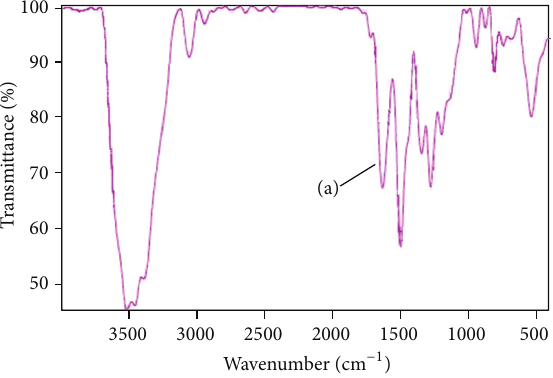
Figure 8: IR spectrum of D301R resin of unloading Ni 2+